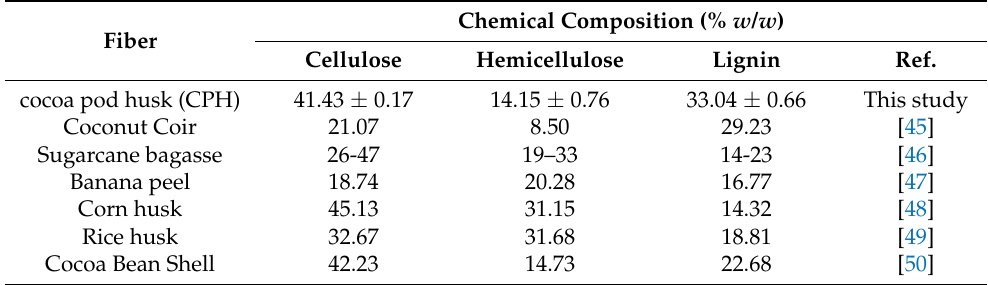
Table 2. Lignocellulosic content of CPH fibers compared to other natural fibers. Fiber